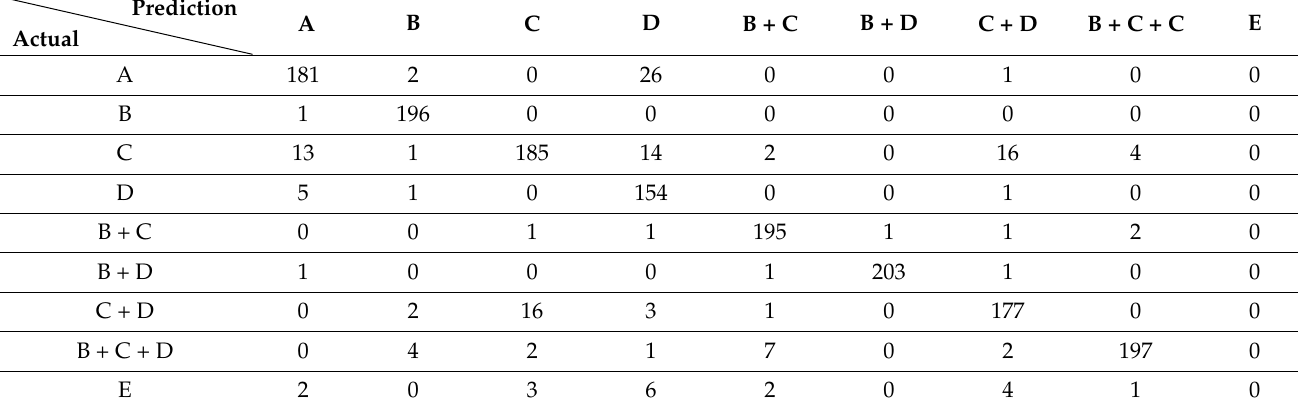
Table 13. Confusion matrix of model based on time-frequency domain